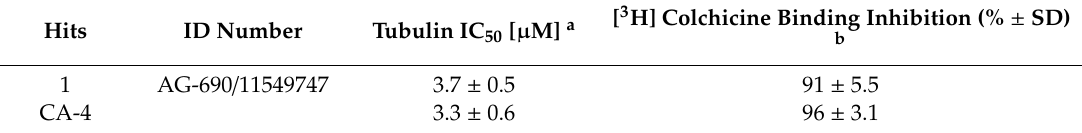
Table 4. Inhibition of tubulin polymerization and [ 3 H] colchicine binding inhibition.